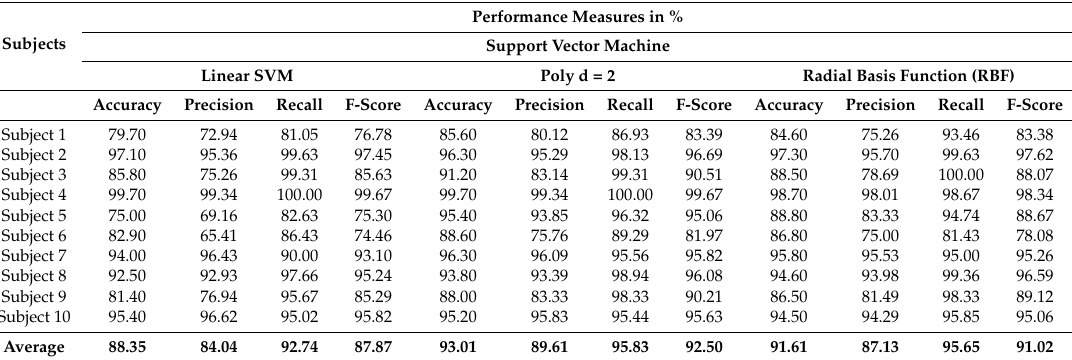
Table 7. 10-fold cross validation (10-CV) identification results using linear and kernel-based (polynomial d = 2 and radial basis function) support vector machine (SVM) including accuracy, precision, recall and F-Score with the reduced 7D feature